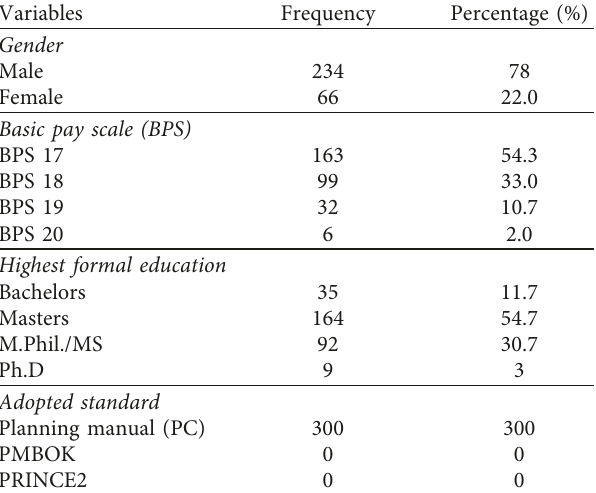
Table 3: Respondent’s contextual